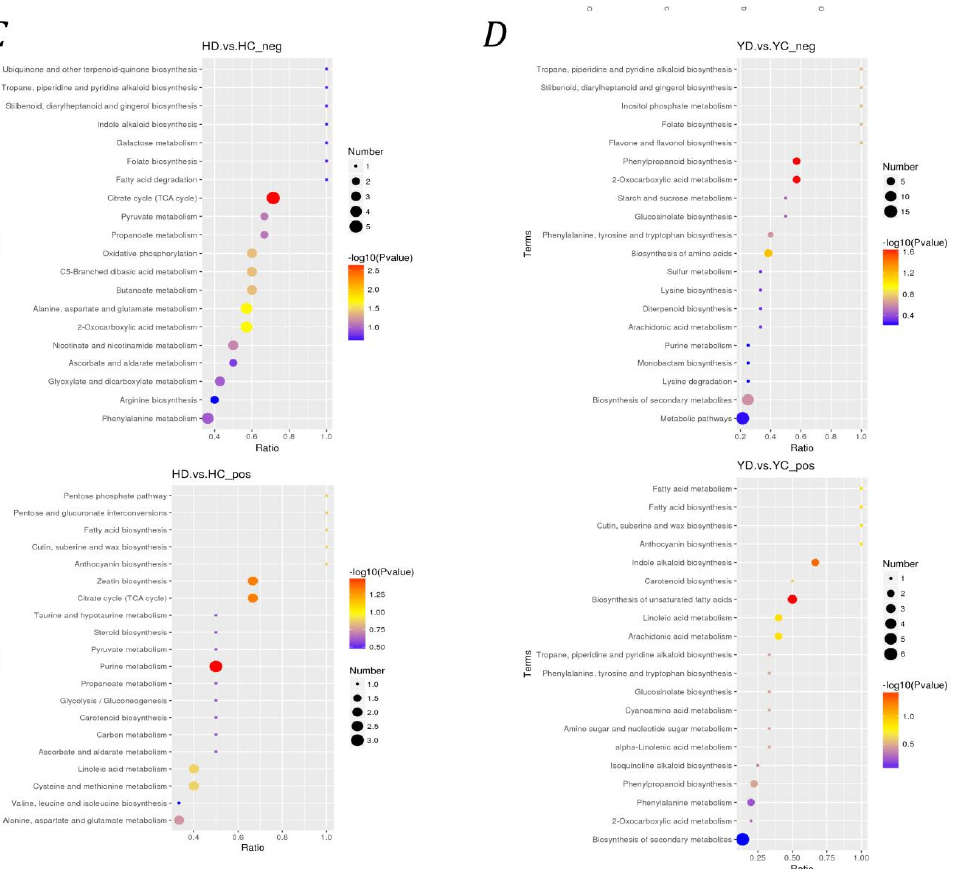
Int. J. Mol. Sci. 2022 , 23 , x FOR PEER REVIEW Figure A2. Differential analysis and functional analysis of metabolites. ( A ): Venn diagram of the number of different metabolites. ( B ): Heatmap of the expression of metabolites that differ in positive ion mode and negative ion mode. ( C ): KEGG enrichment analysis of the DEMs in the HD vs. HC comparison. ( D ): KEGG enrichment analysis of the DEMs in the YD vs. YC comparison.